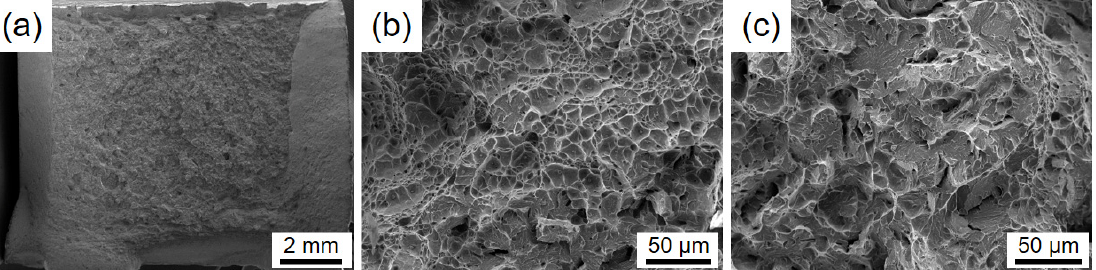
Figure 7. Morphology of fracture surface of Q950 impact tested specimen. ( a ) overall macro-morphology of fracture surface, ( b ) micro-morphology of fracture surface close to the notch, ( c ) micro-morphology of fracture surface at the center.